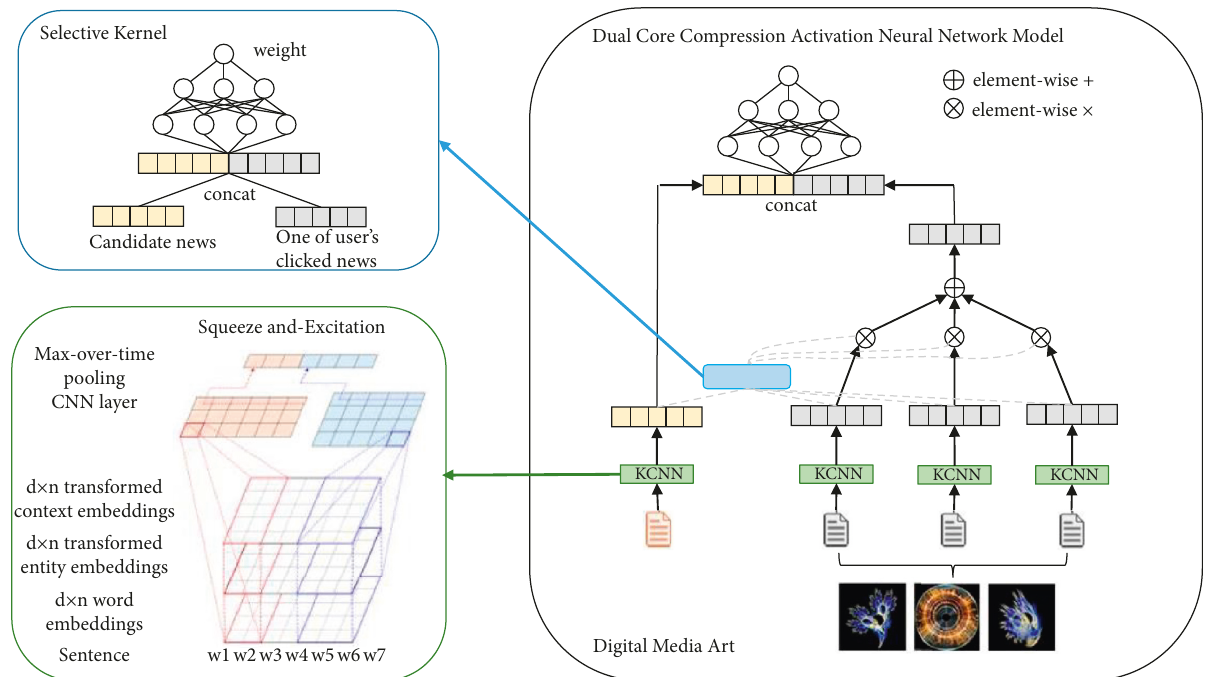
Figure 6: Schematic diagram of algorithm framework structure.